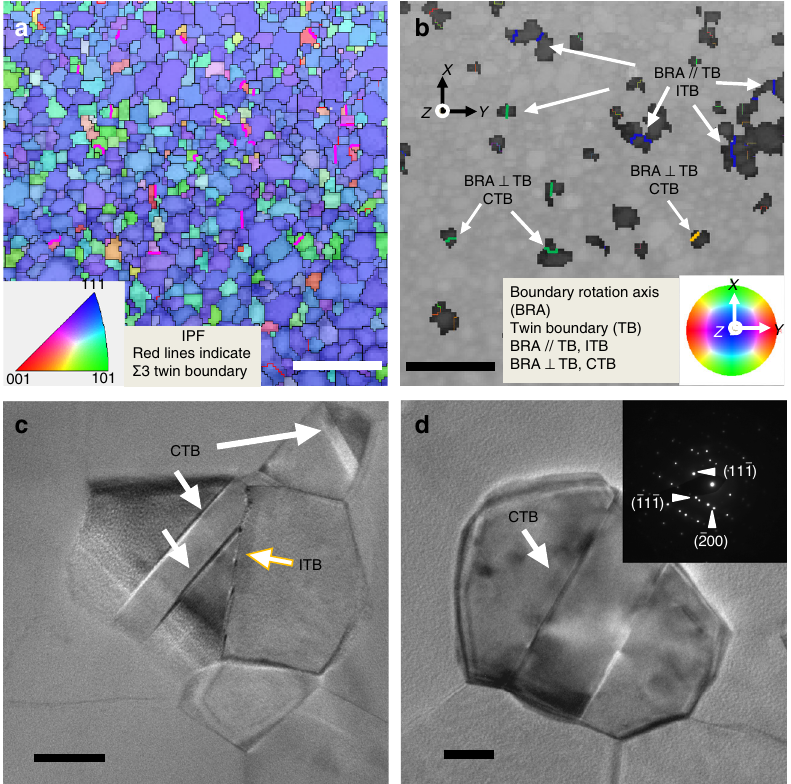
Fig. 1 Microstructures of as-deposited ultra fi ne grained (UFG) Al thin fi lm. a EBSD micrograph showing orientation map along the sample surface normal direction; the red lines indicate ∑ 3 twin boundaries. Scale bar, 1 µ m. b The boundary rotation axis (BRA) map reveals the incoherent twin boundary (ITB) (when BRA//TB) and coherent twin boundary (CTB) (when BRA ⊥ TB). Scale bar, 1 µ m. c , d Plan-view TEM images showing growth twins in as-deposited UFG Al thin fi lms (inset of d shows the selected area diffraction (SAD) pattern of a grain containing growth twins). Scale bar, 20